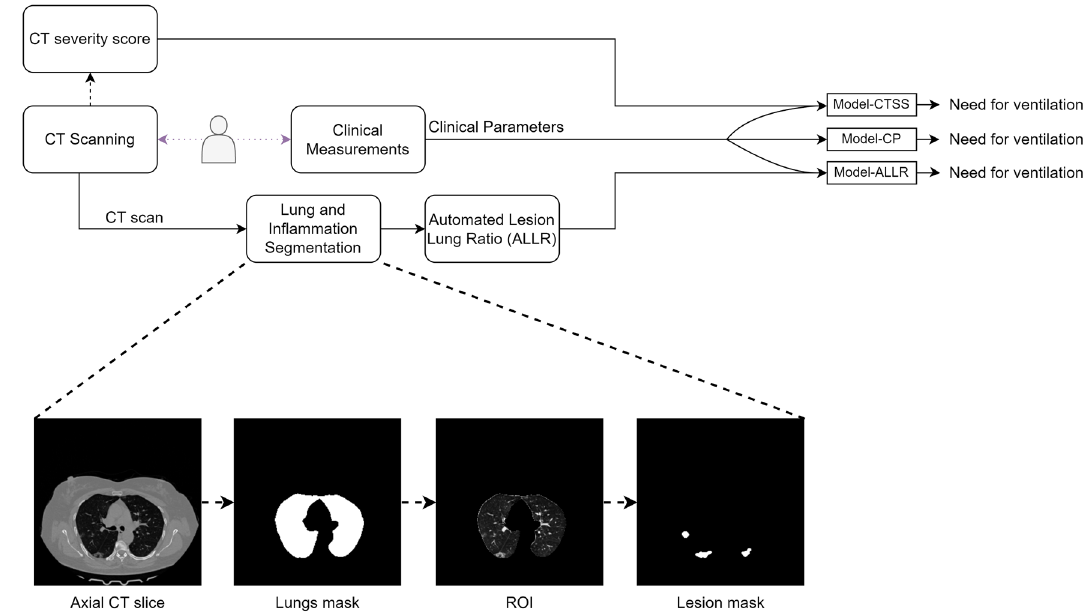
Figure 1. Flowchart. Top panel shows the flow chart of the project. This shows the experiment of training 3 models on different feature sets. Model-CP was trained only on clinical parameters. Model-CTSS was trained on clinical features appended with CT severity score. Model-ALLR was trained on clinical features appended with ALLR. The bottom panel is the expanded view of lung and inflammation segmentation. The lungs mask are produced by a segmentation model from CT scan. This mask is used to get the region of interest (ROI). The ROI is given as input to another segmentation model that produces the inflammation masks.